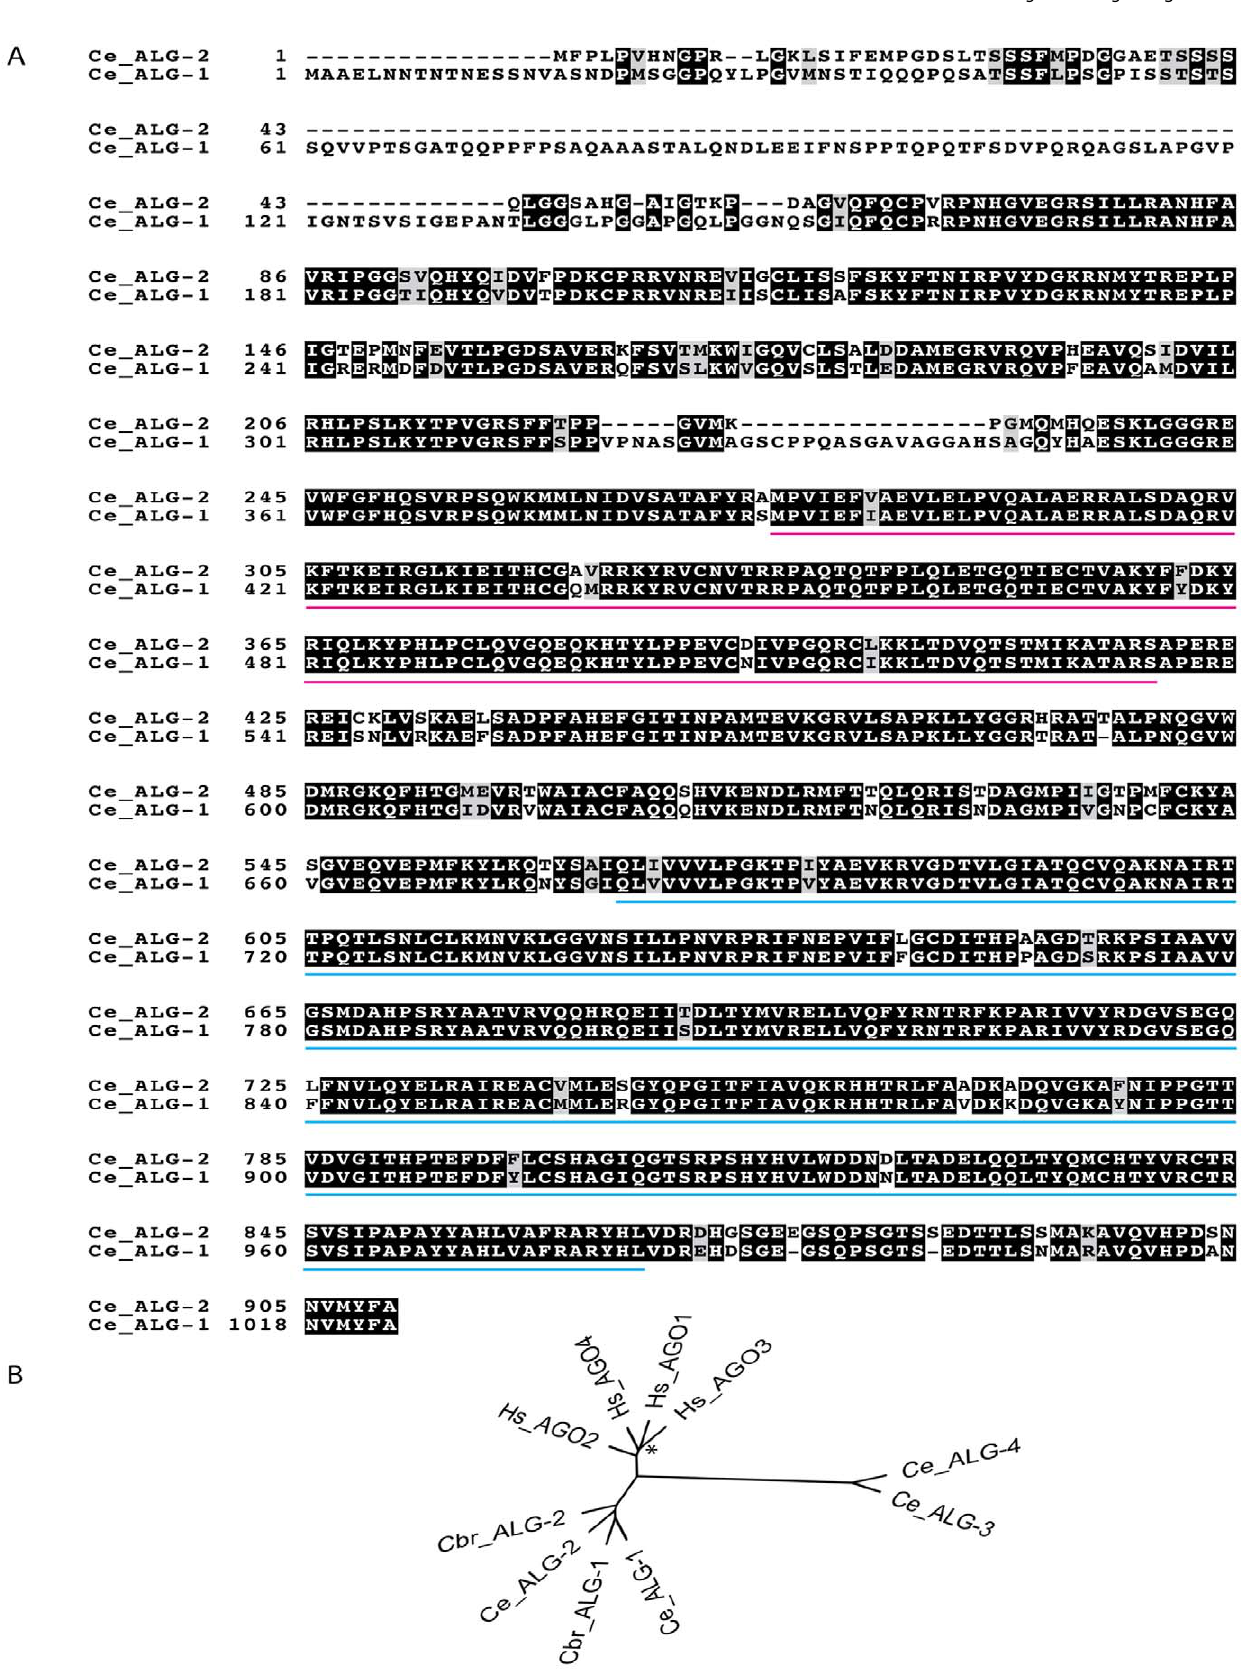
Figure 1. The C.elegans microRNA Argonautes alg-1 and alg-2 . ( A ) Amino acid sequence alignment between ALG-1 and ALG-2 proteins (77% identity and 81% similarity). Identical (black) and similar (grey) residues as well as the PAZ (pink) and PIWI (blue) signature domains are indicated. ( B )